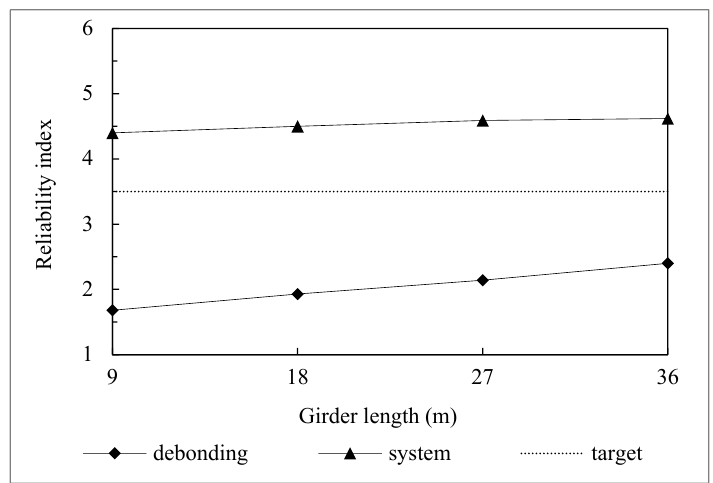
Figure 8. Reliability indices of specimens using Sika H514.